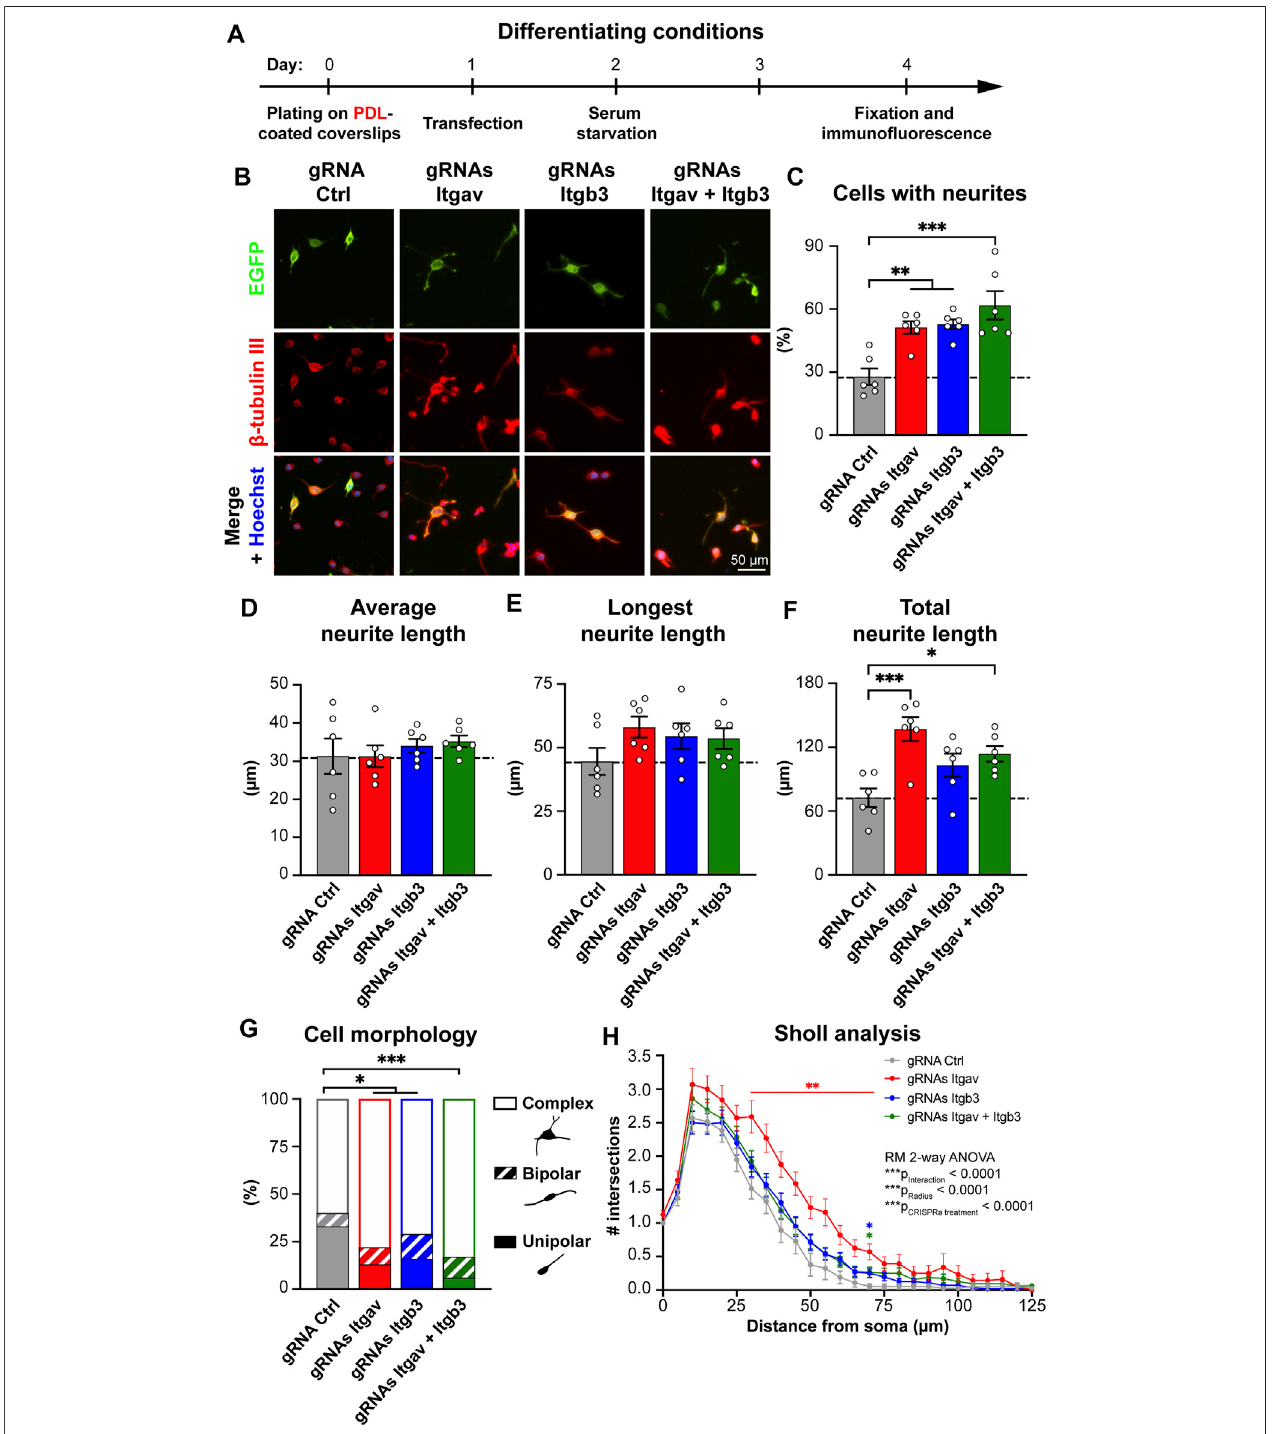
FIGURE 3 | CRISPR-mediated activation of Itgav supports complex neurite arborization of differentiated N2a cells. (A) Time course of the experiment. (B) Representative images of N2a cells expressing the indicated constructs. Transfection was veri fi ed by EGFP expression, β -tubulin III staining was used to trace neurites and Hoechst to stain nuclei. (C) Percentage of cells with neurites within EGFP-positive cells for experiments as in (A,B) . ** p < 0.01, *** p < 0.001, one-way ANOVA followedbyTukey ’ spost-test( n =6coverslipsfrom5independentexperiments).CRISPRaforeither Itgav or Itgb3 orbothdoublesthepercentageofdifferentiated N2a cells, as compared to control conditions. (D – F) Average (D) , longest (E) and total neurite length (F) of differentiated N2a cells expressing the indicated constructs. * p < 0.05, *** p < 0.001, one-way ANOVA followed by Tukey ’ s post-test ( n = 6 coverslips from 5 independent experiments). (G) Morphological classi fi cation